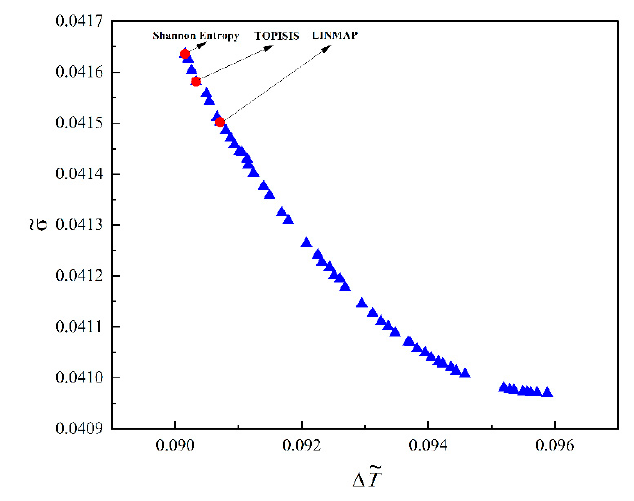
continuously. Therefore, it was necessary to find the optimal constructs of (cid:101) L 1 and (cid:101) L 2 . Compared with Figure 2, the minimum values of ∆ (cid:101) T and (cid:101) σ on Pareto frontiers were reduced. From Figure 5, in the Pareto frontiers under two-DOF optimization, (cid:101) L 1 was distributed between 0.0911 and 0.0991, (cid:101) L 2 was distributed between 0.4876 and 0.4980, and the optimal solutions with minimum ∆ (cid:101) T and (cid:101) σ of (cid:101) L 1 and (cid:101) L 2 were on the boundary of the distribution range.